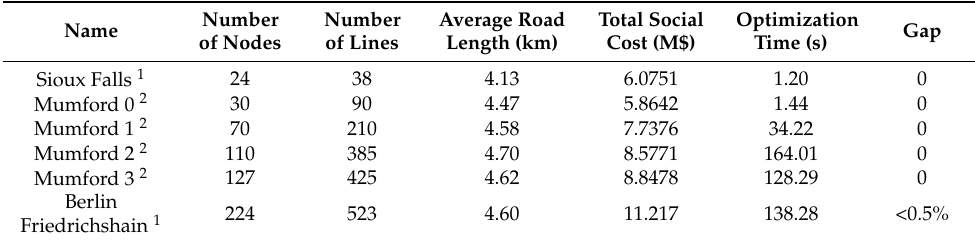
Table 3. Computational efficiency of the MILP model for different network scales. All numerical examples have the same parameter settings as the case based on Sioux